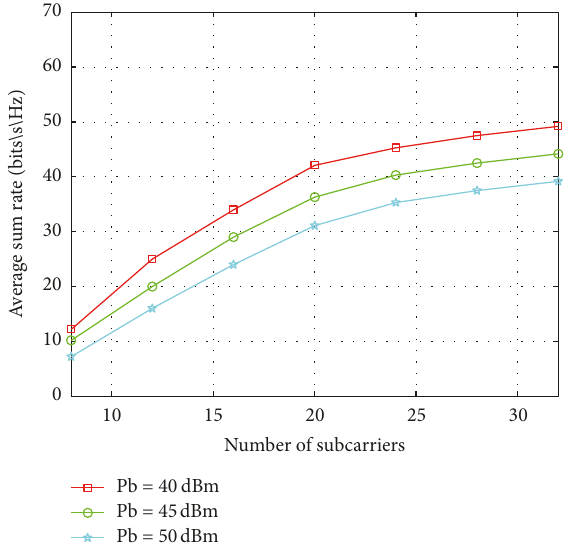
Figure 6: Operator’s profits versus different number of users.